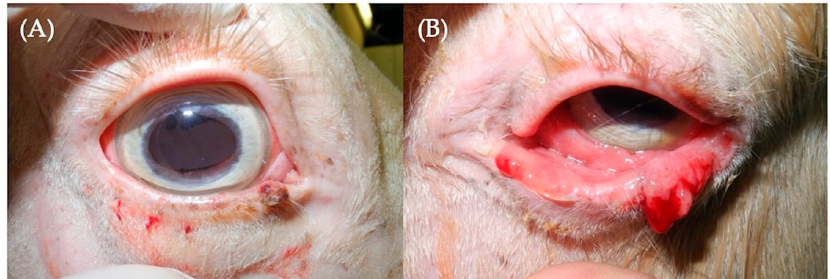
Figure 2. Clinical photographs of the right ( A ) and left ( B ) eyes of a Connemara Pony (Case 2). Note the ulcerated mass on the nasal inferior eyelid OD ( A ) and the extensive masses affecting the lower eyelid OS ( B ).